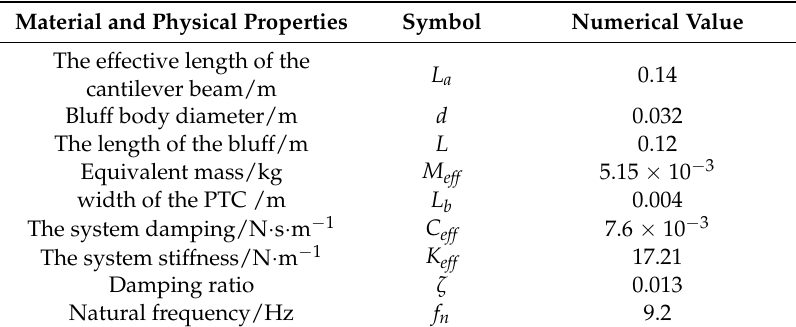
Table 2. Parameters of the